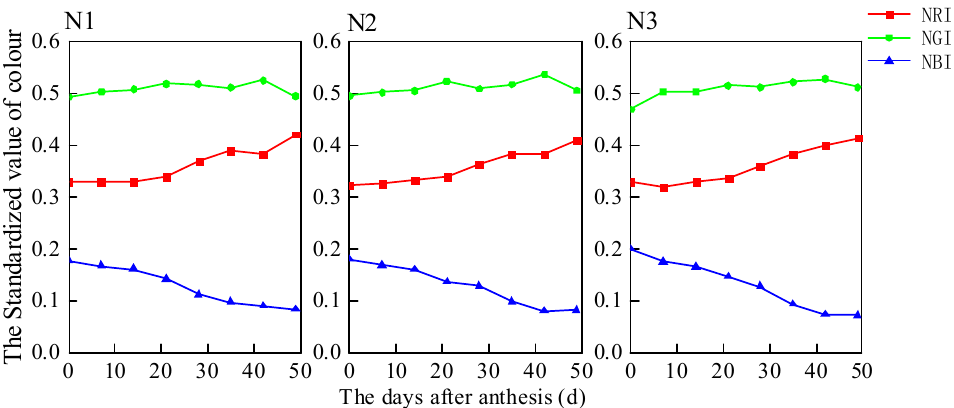
Figure 8. Dynamic changes in the standardized values of color for leaves with high, medium, or low nitrogen supplies in CY5 after anthesis.